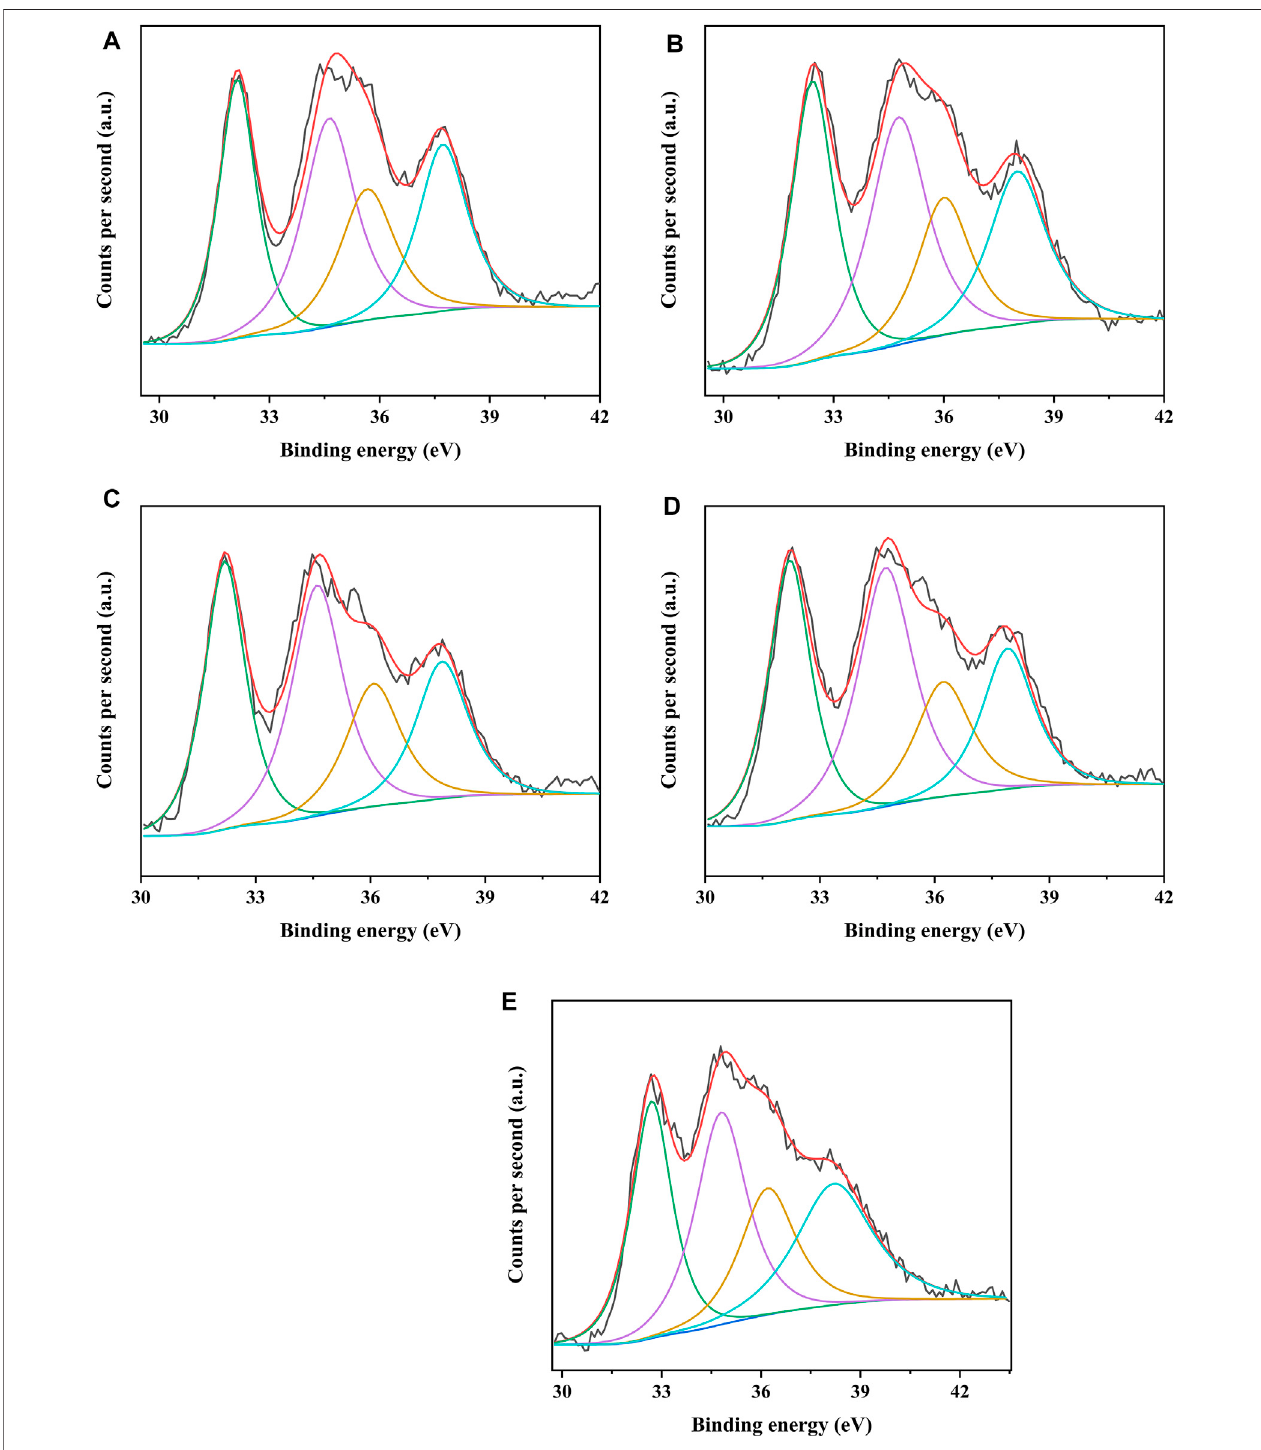
FIGURE 8 | XPS W 4f spectra of sul fi ded catalysts: (A) NiW/4Ni-SAPO-11, (B) NiW/3Ni-SAPO-11, (C) NiW/2Ni-SAPO-11, (D) NiW/1Ni-SAPO-11, and (E) NiW/ SAPO-11.